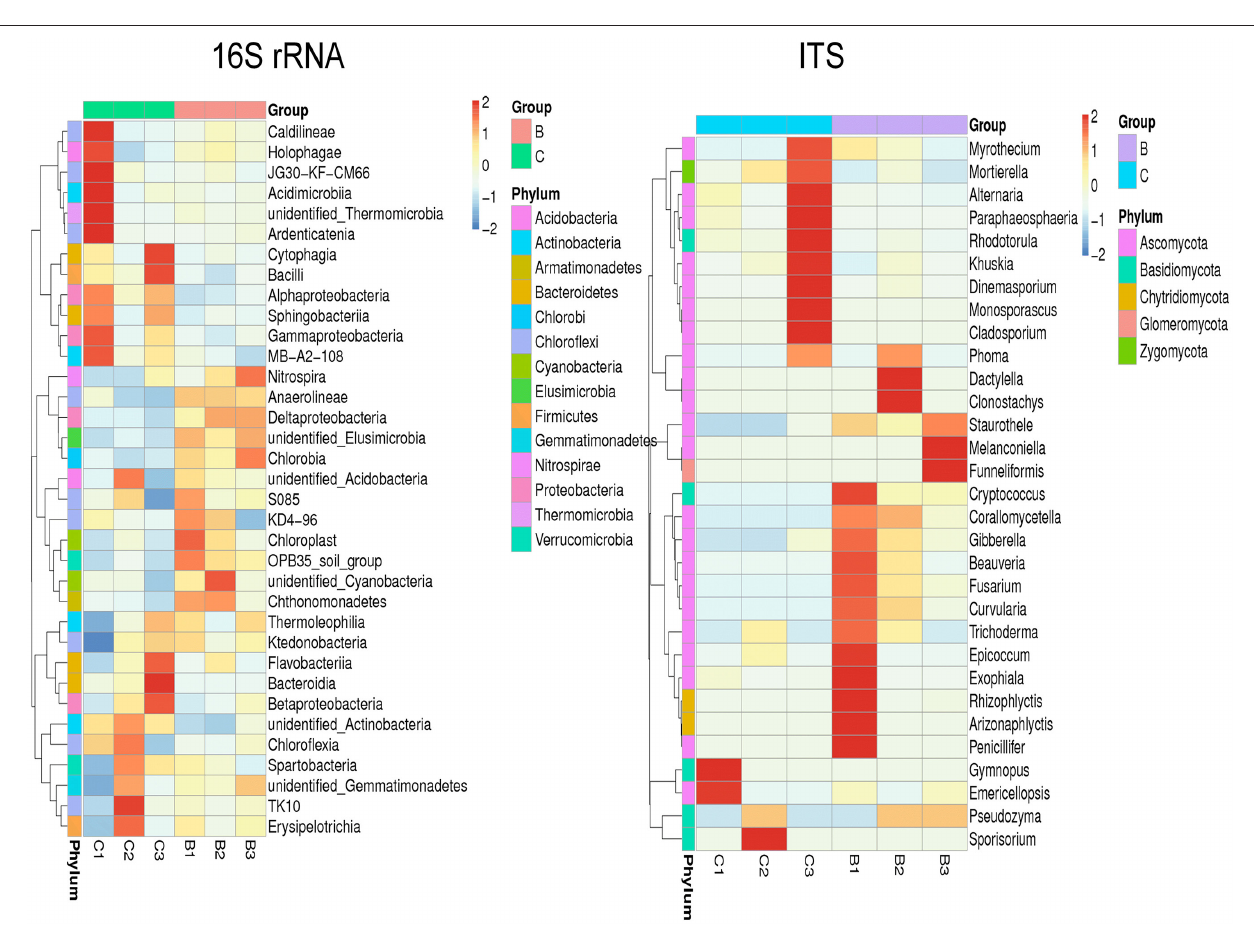
colors represent diverse phylum, and solid circles represent